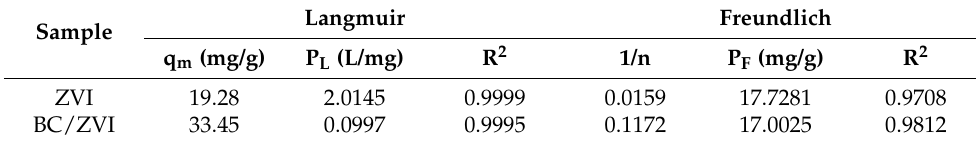
Table 3. The isothermal thermodynamic parameters of Cu(II) adsorption on BC